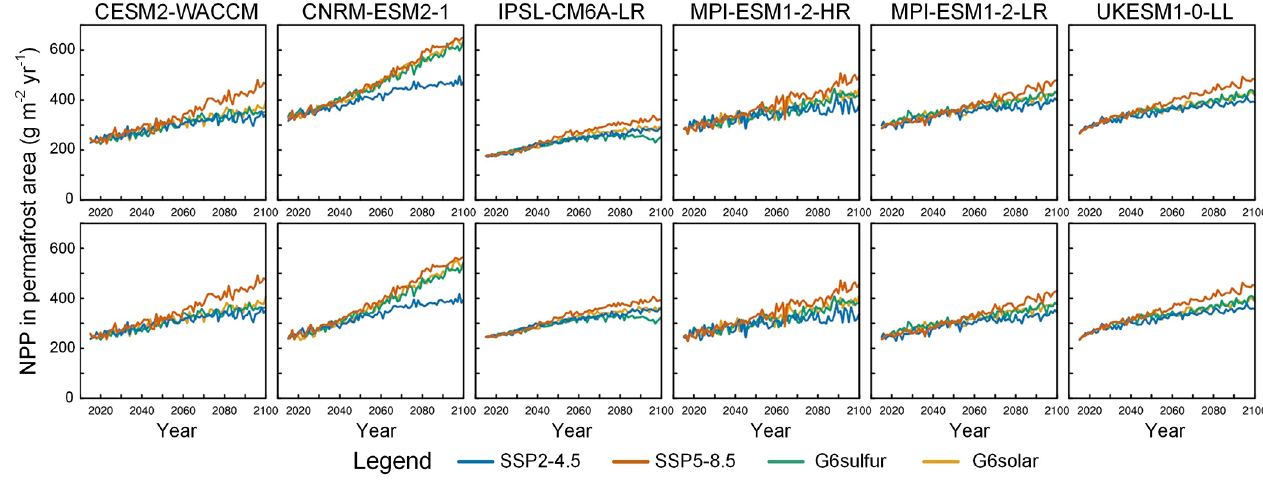
Figure 2. Bias correction of net primary productivity (NPP). Mean NPP in the permafrost region before (top row) and after (bottom row) bias correction. The bias correction offsets for each ESM are shown in Table